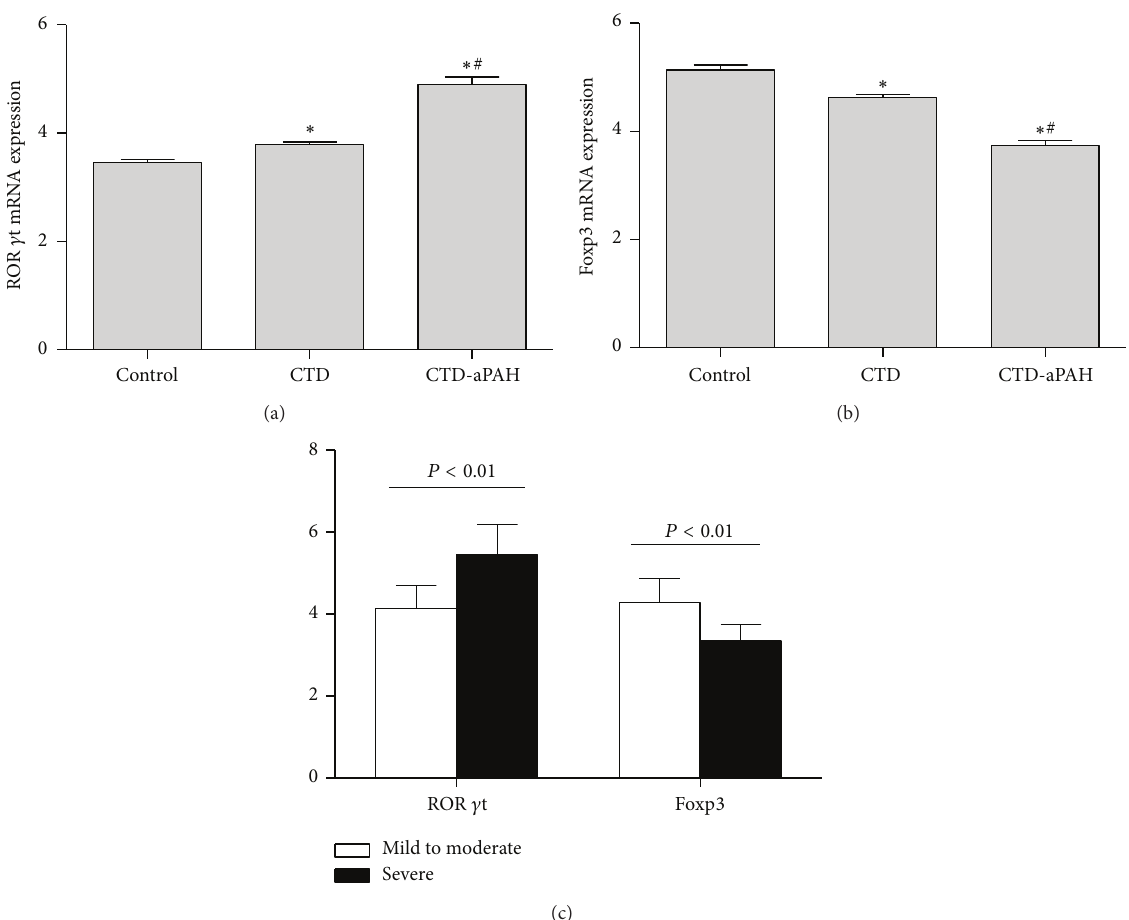
Figure 2: Expression of ROR 𝛾 t and Foxp3 mRNA in CTD and CTD-aPAH patients and healthy controls. mRNA expression in PBMCs from studied subjects was measured by real-time quantitative polymerase chain reaction. The result was normalized relative to GAPDH. (a) The expression of ROR 𝛾 t mRNA in CTD, CTD-aPAH, and control group. (b) The expression of Foxp3 mRNA in CTD, CTD-aPAH, and control group. (c) The expression of ROR 𝛾 t and Foxp3 mRNA in subgroups of mild to moderate CTD-aPAH and severe CTD-aPAH. ∗ Compared with control group, 𝑃 < 0.01 ; # Compared with CTD group, 𝑃 < 0.01